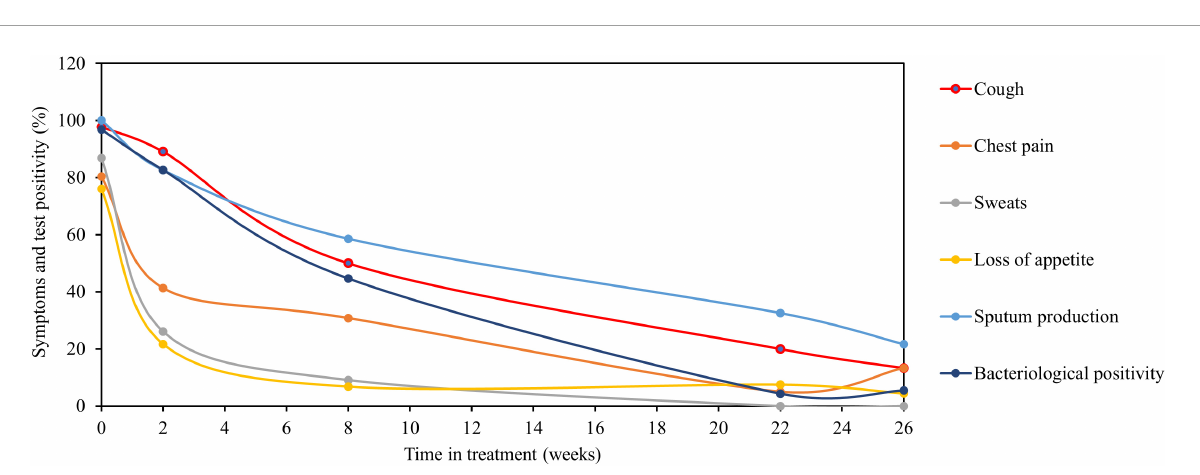
FIGURE3 Average bacteriological positivity compared to clinical symptoms clearance. Relationship of clinical symptoms clearance compared to average bacteriological positivity of TB-MBLA and culture. Clinical symptoms (sweats, loss of appetite, and chest pain) resolved more rapidly than the average bacteriological positivity. Resolution of cough was slow matching the resolution of average bacteriological positivity, while sputum production resolved more slowly than average bacteriological positivity. Data are presented as the percentage (%) of patients with clinical symptoms and average bacteriological positivity over the time in treatments (weeks). The average bacteriological positivity ( ± SD) was 96.7 ± 4.6, 82.6 ± 9.2, 44.6 ± 23.1, 4.3 ± 0, and 6.5 ± 3.04 at baseline (week 0), weeks 2, 8, 22, and 26,